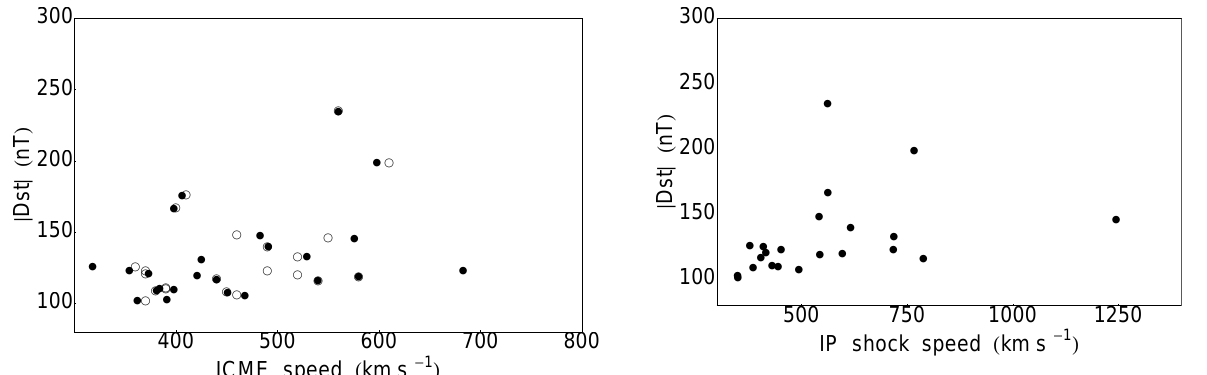
The used ICME and IP shock catalogs provide a number of additional parameters, e.g., averaged magnetic field B and plasma speed V inside the magnetic structure, upstream plasma beta β u (not shown in Table 1). No strong correlations are obtained between these parameters and the Dst index as all correlation coefficients found were smaller than 0.2.